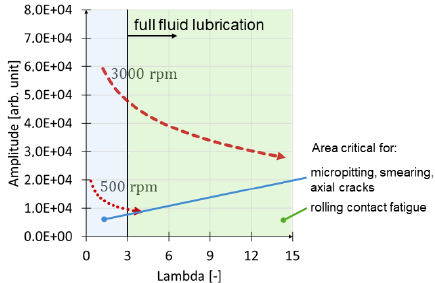
Figure 8. AE results arranged with the lubrication regimes. Arb. unit: arbitrary unit.